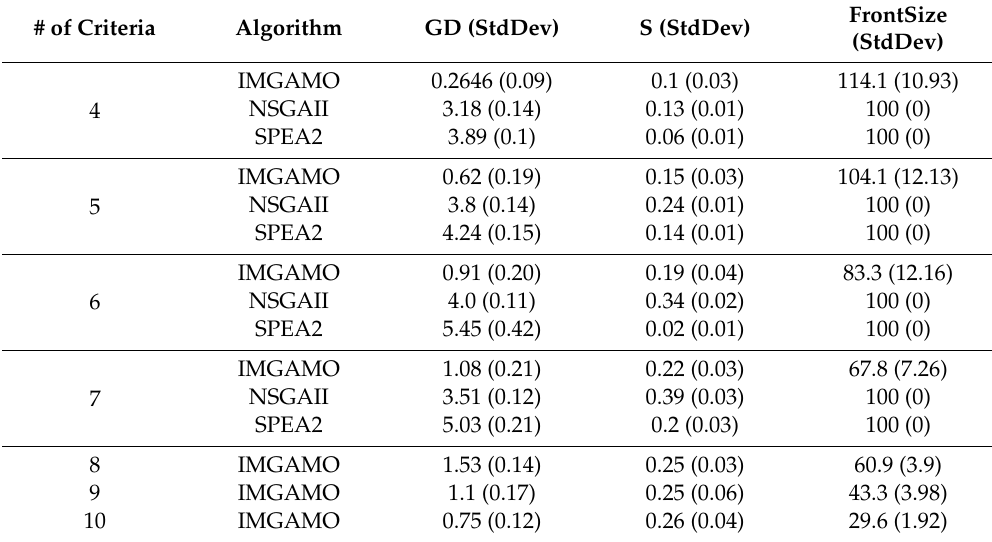
Table A8. Comparison of results for DTLZ5